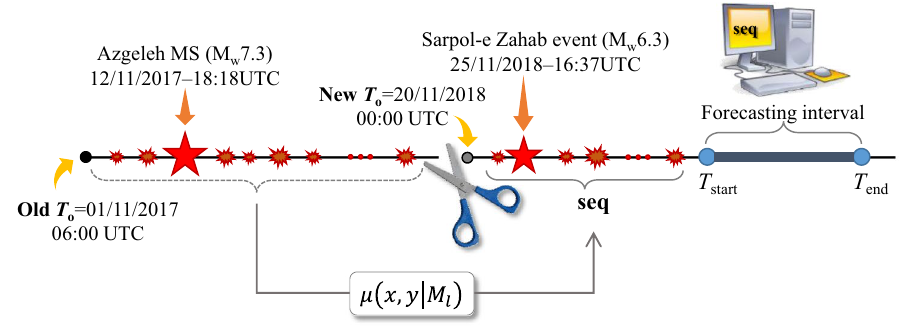
Figure 6. Sketch showing the shift in the time of origin T o